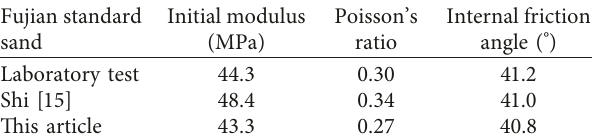
Table 4: Parameters of numerical simulation and laboratory test.